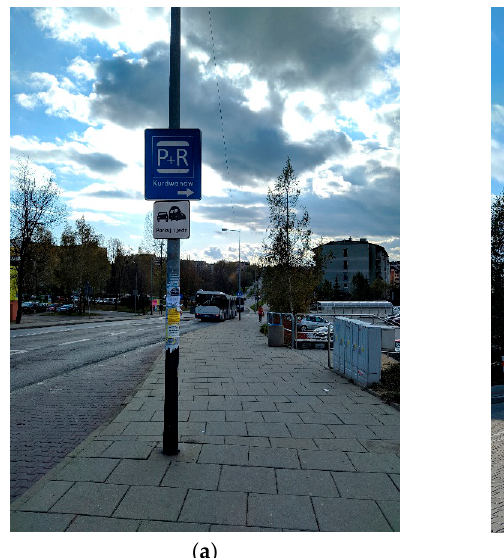
( b ) ( c ) Figure 3. Views of the analyzed P&R parking in Cracow: ( a ) Czerwone Maki; ( b ) Kurdwanów; ( c ) Bie ż anów. Table 2. Possibilities of changing the means of transport in the analyzed P&R parking in Cracow. Parking P& R